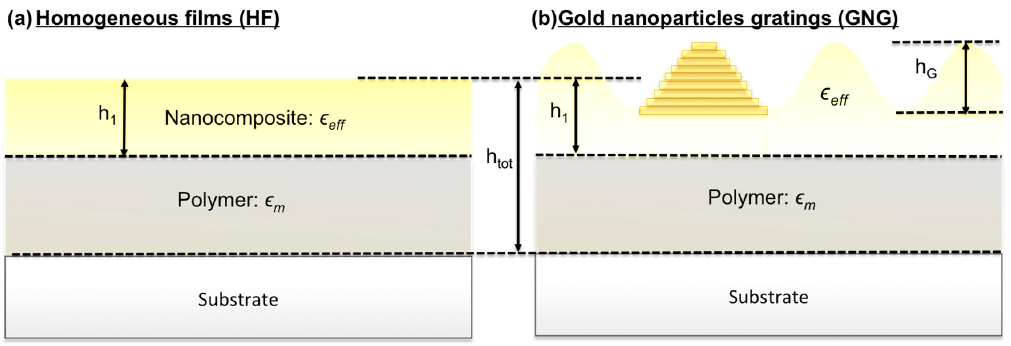
Figure 3. Parameterization of ( a ) the HFs and ( b ) the GNGs in the frame of the RCWA method.